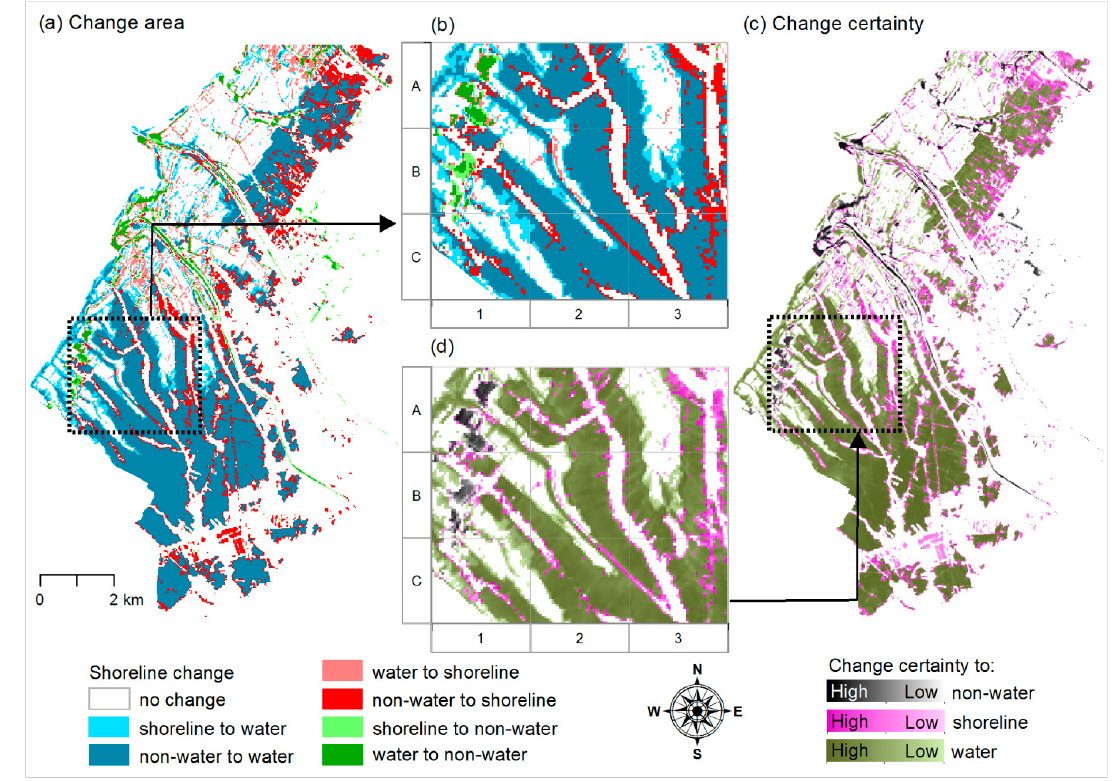
Figure 19. Shoreline change ( a , b ) and its related change certainty ( c , d ) between 1988 and 2017. Large changes from non-water into water (turquoise) indicating a permanent inundation of the area are mostly related to the high certainty of change into water (dark green), whereas large changes of non-water into shoreline (red) might indicate the area which was inundated gradually.